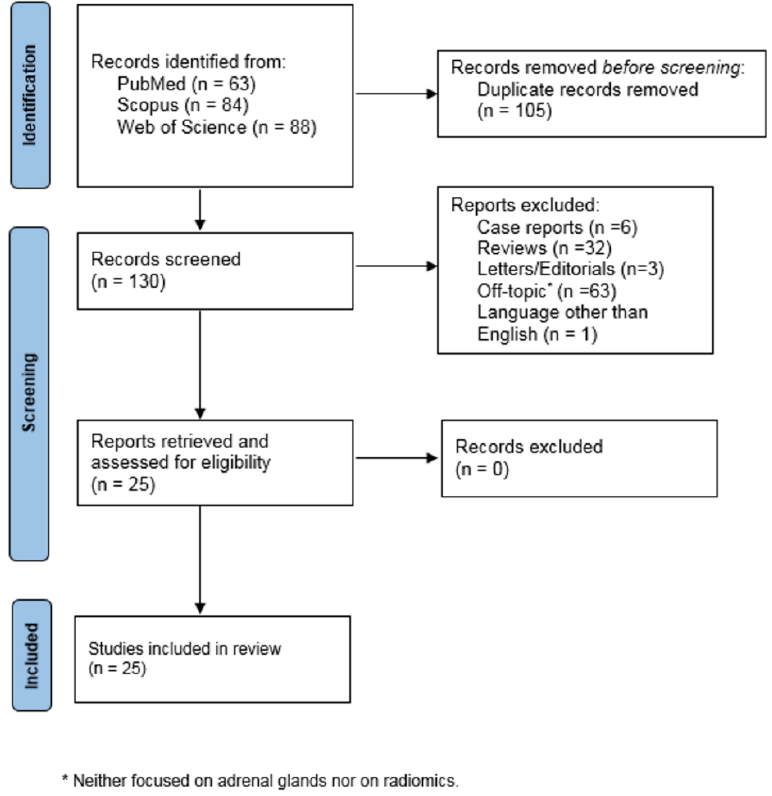
Figure 1. Literature search and study selection flow-chart.